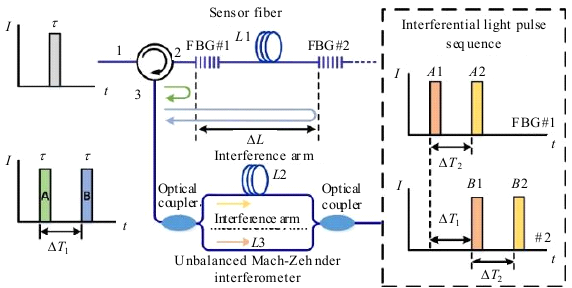
Fig. 2 Principle of vibration source positioning. Δ T 1 is the delay of reflection from FBG#1 and FBG#2, and Δ T 2 is the delay of optical pulse traveling through the unbalanced MZI.  is the width of optical pulse.